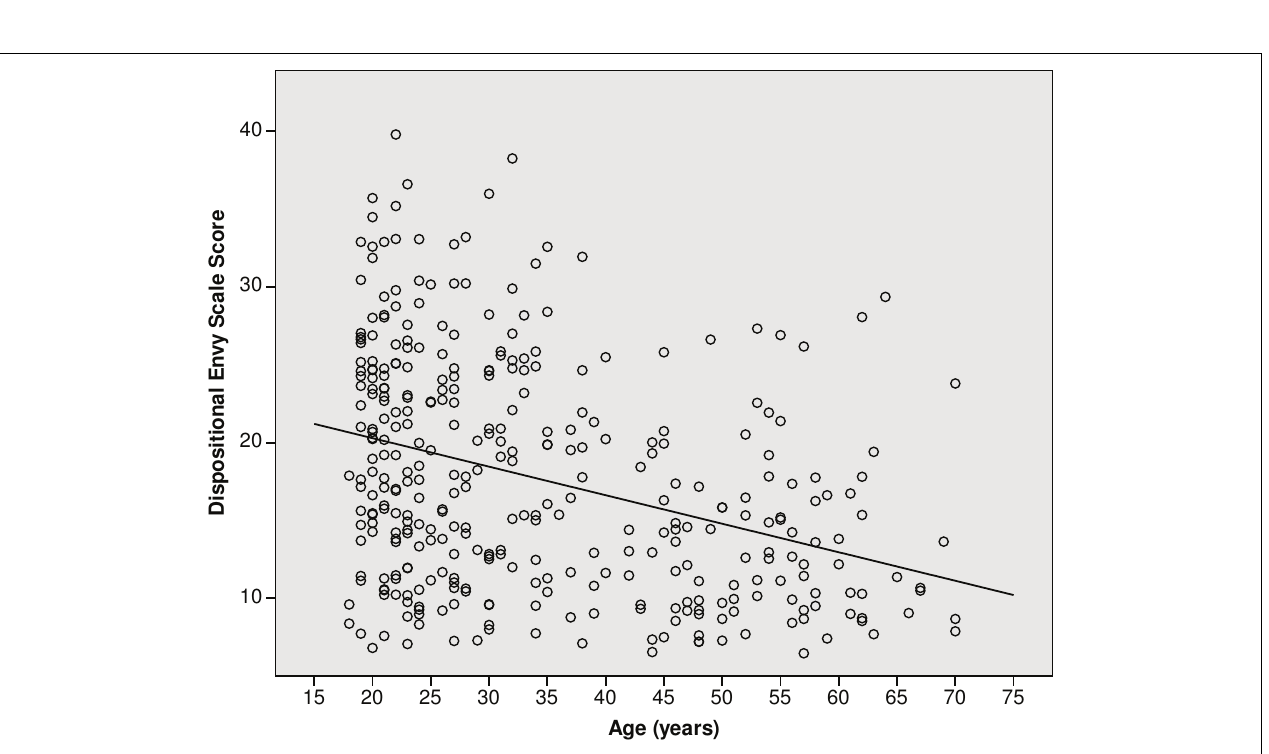
FIGURE 1 | Relationship between political ideology and dispositional envy. Note: horizontal and vertical position has been jittered for better viewing.